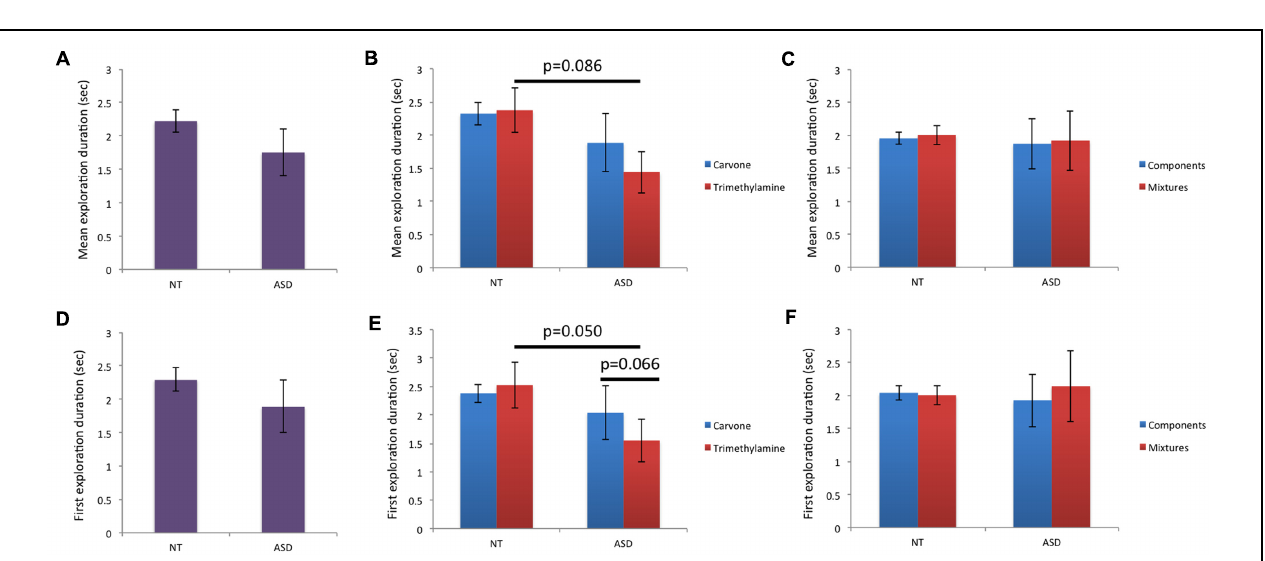
FIGURE 3 | Behavioral data (i): total duration of explorations and number of olfactory explorations. (A–C) No significant effect of group or of odor conditions within groups was observed for total duration of exploration. (D–F) For number of olfactory explorations, no significant effect of group or odor condition (within group) was observed.